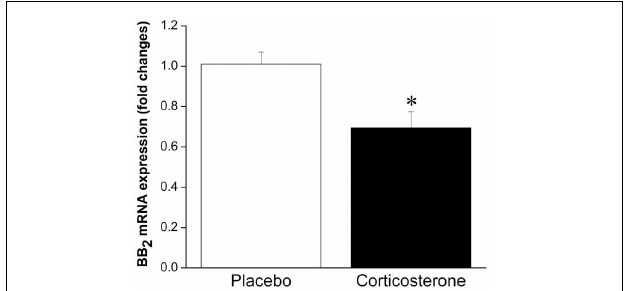
FIGURE 1 | Mean ± SEM (fold change) of mRNA expression of BB 2 at the PVN in placebo or corticosterone pellet (100mg, 21 day slow release) implanted rats. Chronic corticosterone exposure resulted in a significant reduction in BB 2 mRNA expression at the PVN. ∗ Significantly different from placebo at p < 0 . 05.